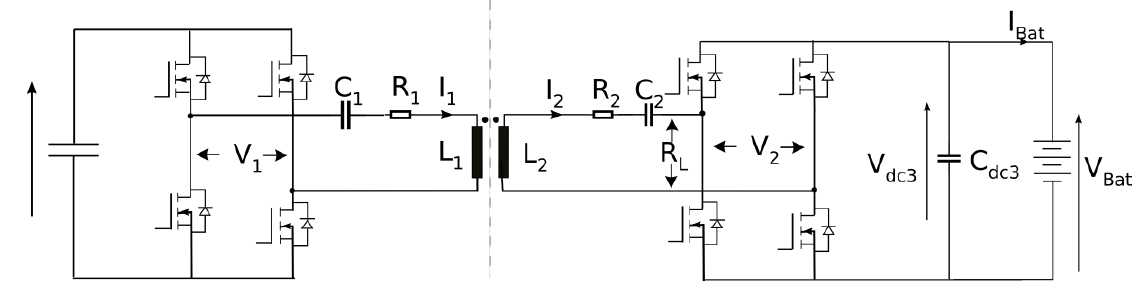
Figure 2. The bidirectional wireless system model for SS topology.